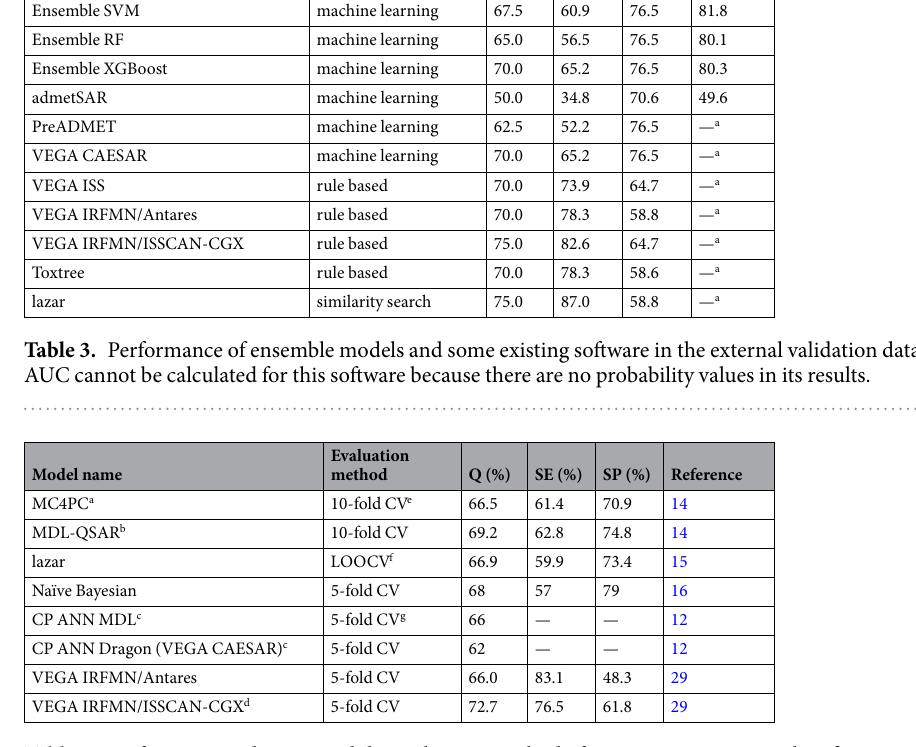
Table 4. Performance indicators and the evaluation method of some carcinogenicity classification models reported in the literature. a The coverage of this model was 96%. b The coverage of this model was 97%. c This study did not provide the SE and SP of the models. d This model was trained using carcinogenesis data from both rats and mice. e Ten-fold cross-validation. f Leave-one-out cross-validation. g Five-fold